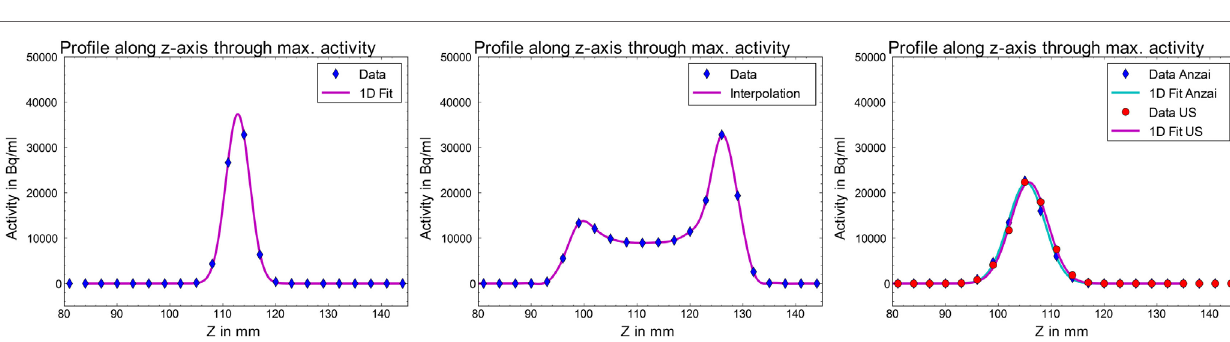
FigUre 5 | comparison of Us- (squares) and anZai-detected (rhombi) motion trajectory . As the US system provides a considerably lower frame rate, the data have been interpolated. A generally good agreement between the two data sets was found. Particularly the positions in time of the inhale peaks agree precisely, typically within 100 ms.